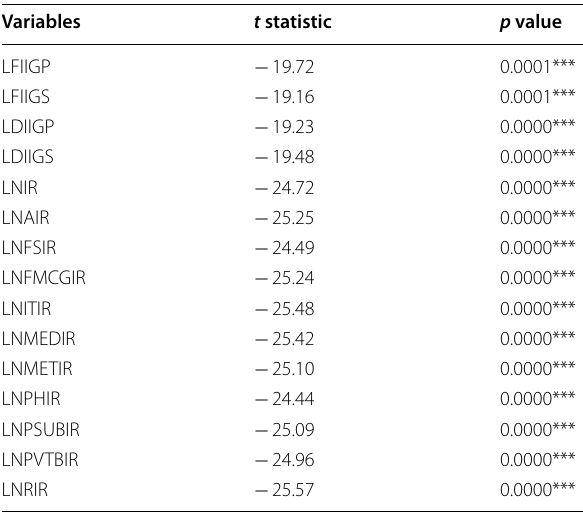
Table 2 Results of stationarity for FIIs, DIIs and stock market returns. Source : Author’s